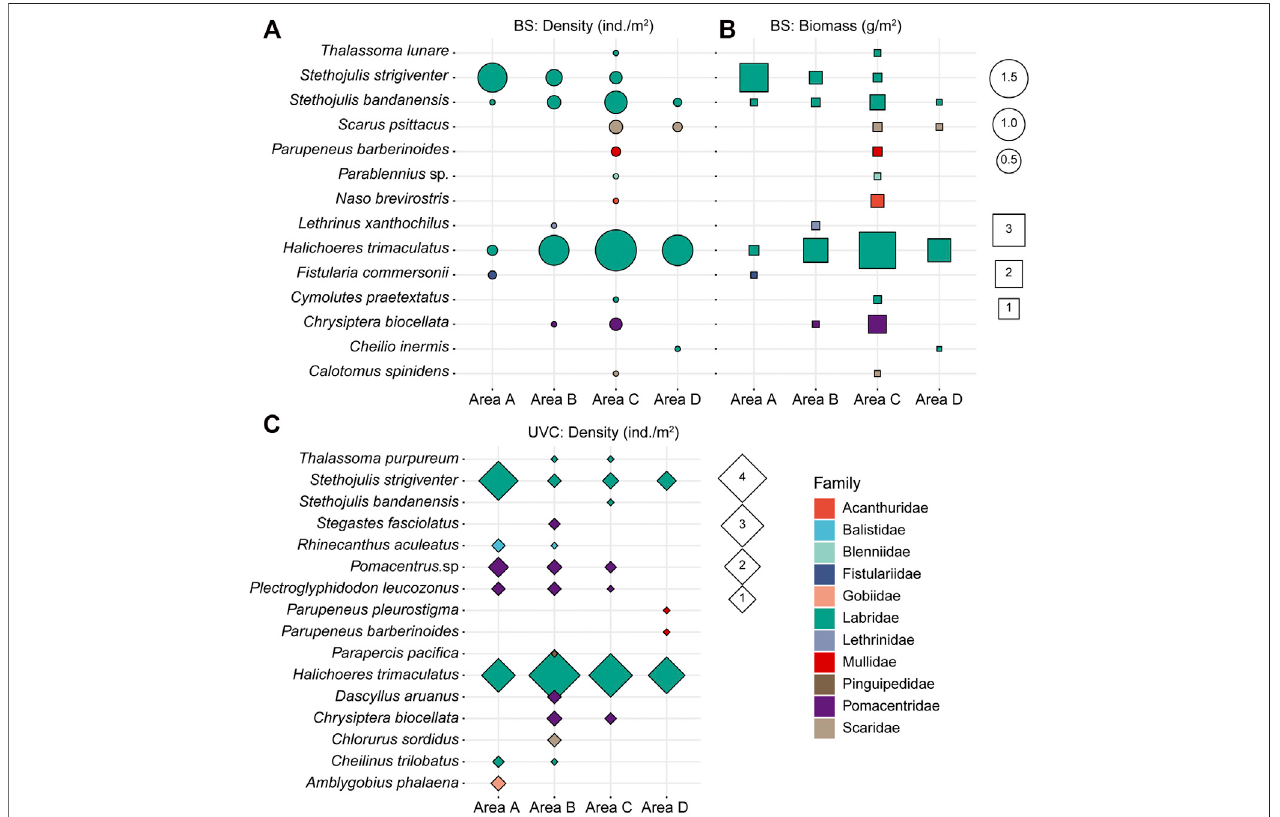
FIGURE4|(A) Density(ind./m 2 )and (B) biomass(g/m 2 )of fi shspeciescollectedusingtheBSmethod. (C) Density(ind./m 2 )of fi